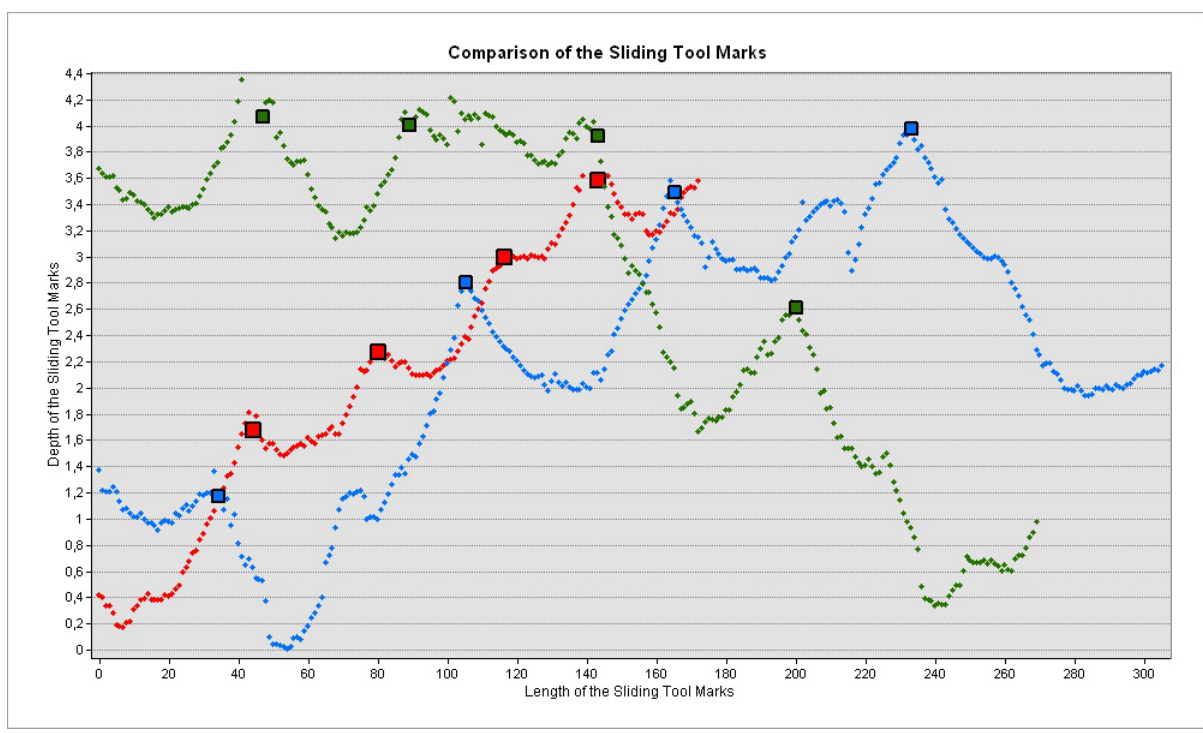
Figure 6. The long profiles of the sliding tool marks along the middle region of the wooden object (in mm) - red points: Hand Tool Nr.1; blue points: Hand Tool Nr.2; green points: Hand Tool Nr.3. The highlighted points represent the calculated watershed boundaries, the borders of the